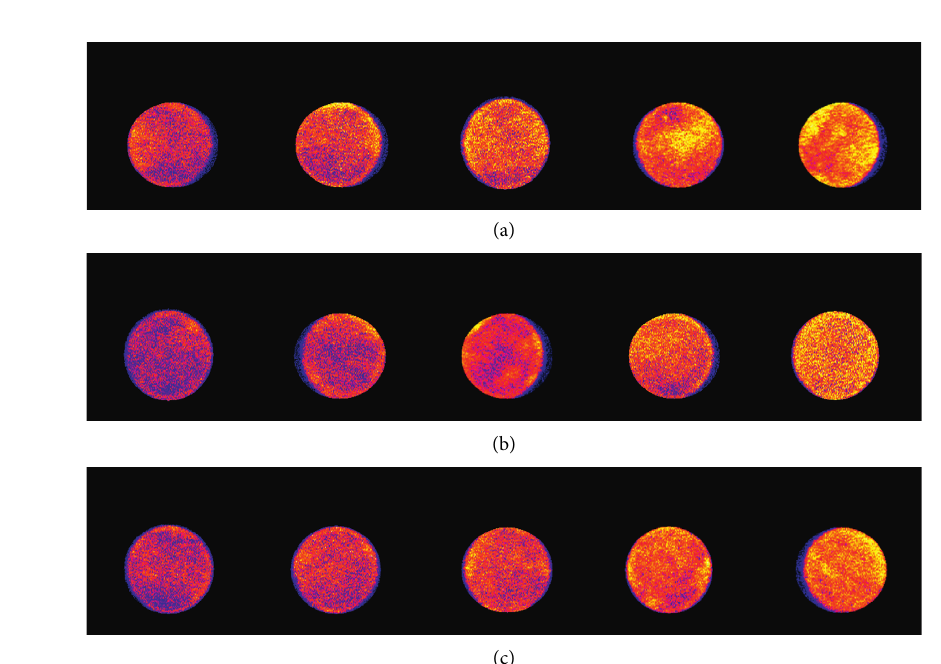
Figure 13: Magnetic resonance images of sandstone samples after different chemical solution erosion and freeze-thaw cycles: (a) images of sandstone samples under acidic solution (from left to right: freeze-thaw cycles are 0, 15, 30, 45, and 60, respectively); (b) images of sandstone samples under neutral solution (from left to right: freeze-thaw cycles are 0, 15, 30, 45, and 60, respectively); (c) images of sandstone samples under alkaline solution (from left to right: freeze-thaw cycles are 0, 15, 30, 45, and 60,